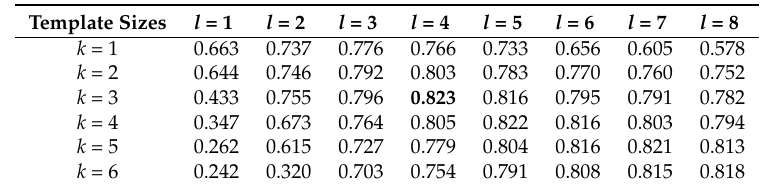
Table 3. Predictive performance of, RPiRLS-7G in terms of the accuracy on the, RPI2662 training data set over varying template sizes.